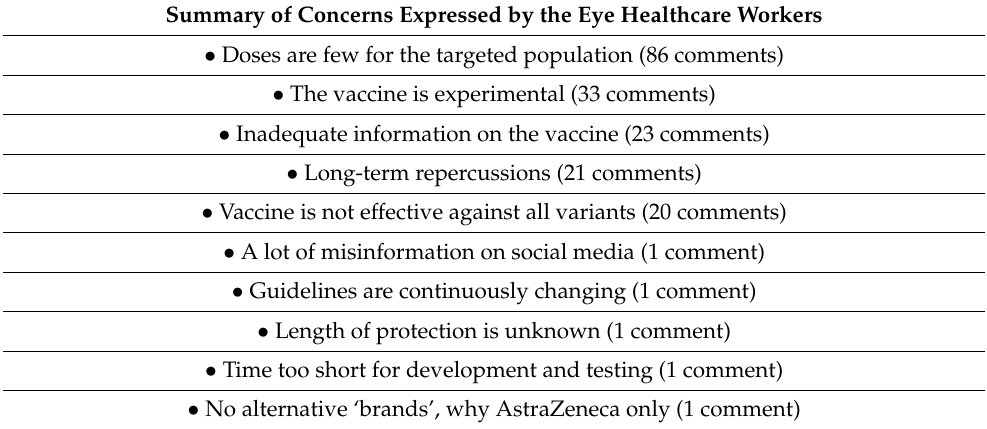
Table 5. Concerns about COVID-19 vaccination by eye health workers in Uganda. Summary of Concerns Expressed by the Eye Healthcare